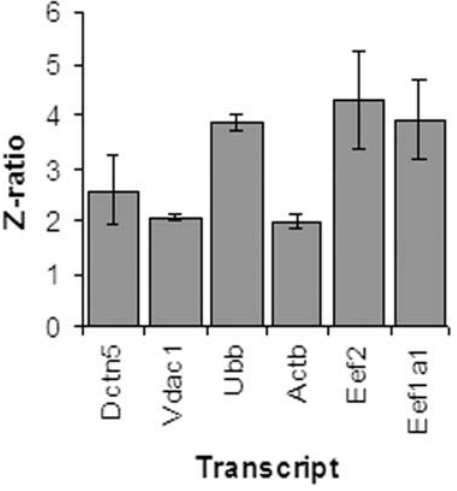
Figure 1. Up-regulation of Dctn5, Vdac1, Ubb, Actb, Eef2 and Eef1a1 in 59QTBP-GFP transfected Neuro-2a cells compared to vector transfected controls observed by cDNA-microarray analysis. X-axis depicts transcript name. Z-ratio of each transcript was plotted on Y axis. Error bar represents mean 6 SEM of at least two independent microarray